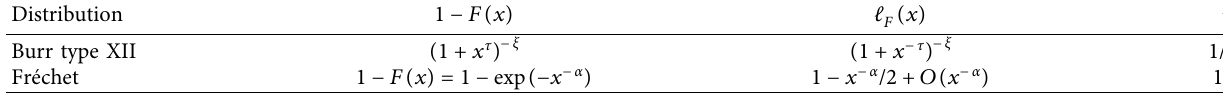
Table 1: Heavy-tailed distributions from the Pareto-type distribution.